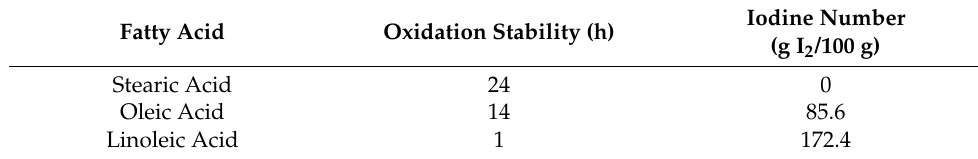
Figure 3. Linear regression between oxidation stability and iodine number. Table 3. The relationship between oxidation stability and iodine number.